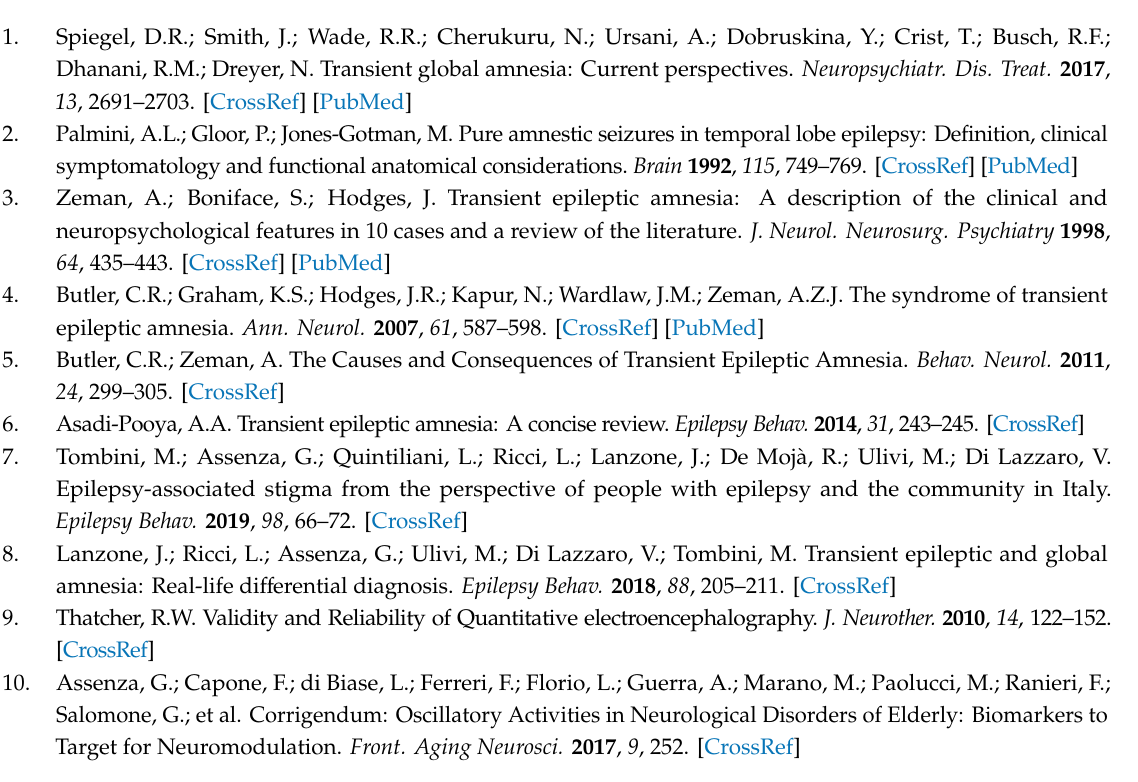
Supplementary Table S1: The table depicts clinical information on the amnesic episodes of patients with Transient Epileptic Amnesia, along with the therapy of choice started after the